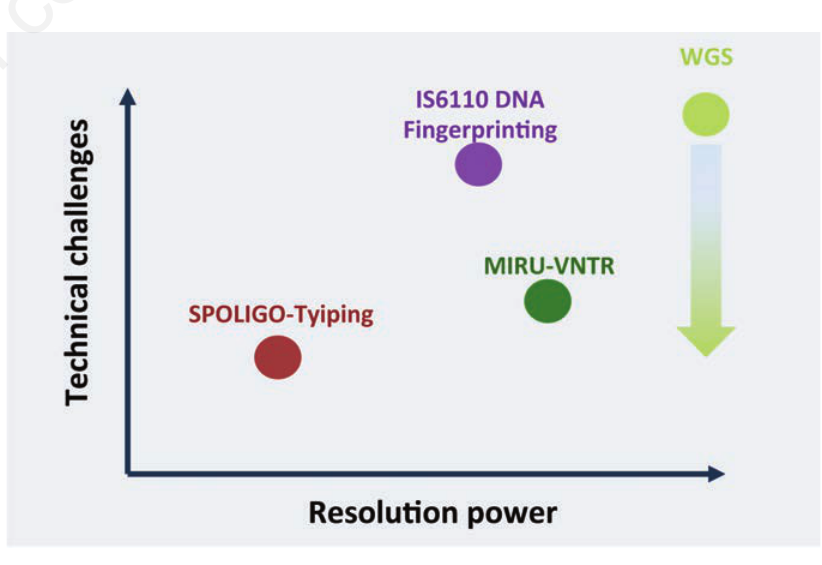
Figure 1. The different methods used in molecular typing of Mycobacterium tuberculosis show different features in terms of technical challenges and resolution power of the genetic distances between the strains